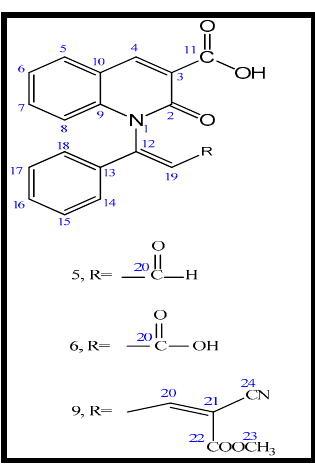
Figure 5. The structure of the derivatives 5 , 6, and 9 .